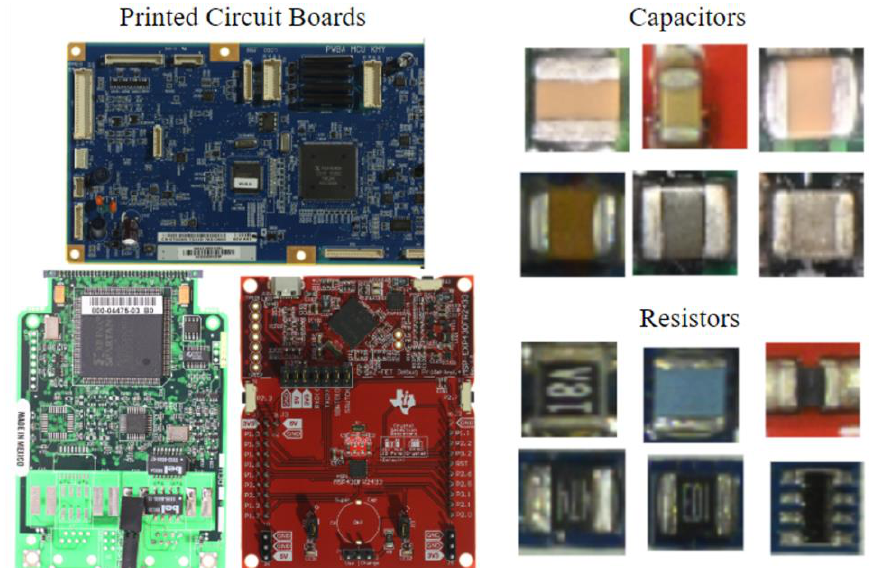
Figure 38. Sample data from the Florida Institute for Cybersecurity (FICS)-PCB dataset [121].